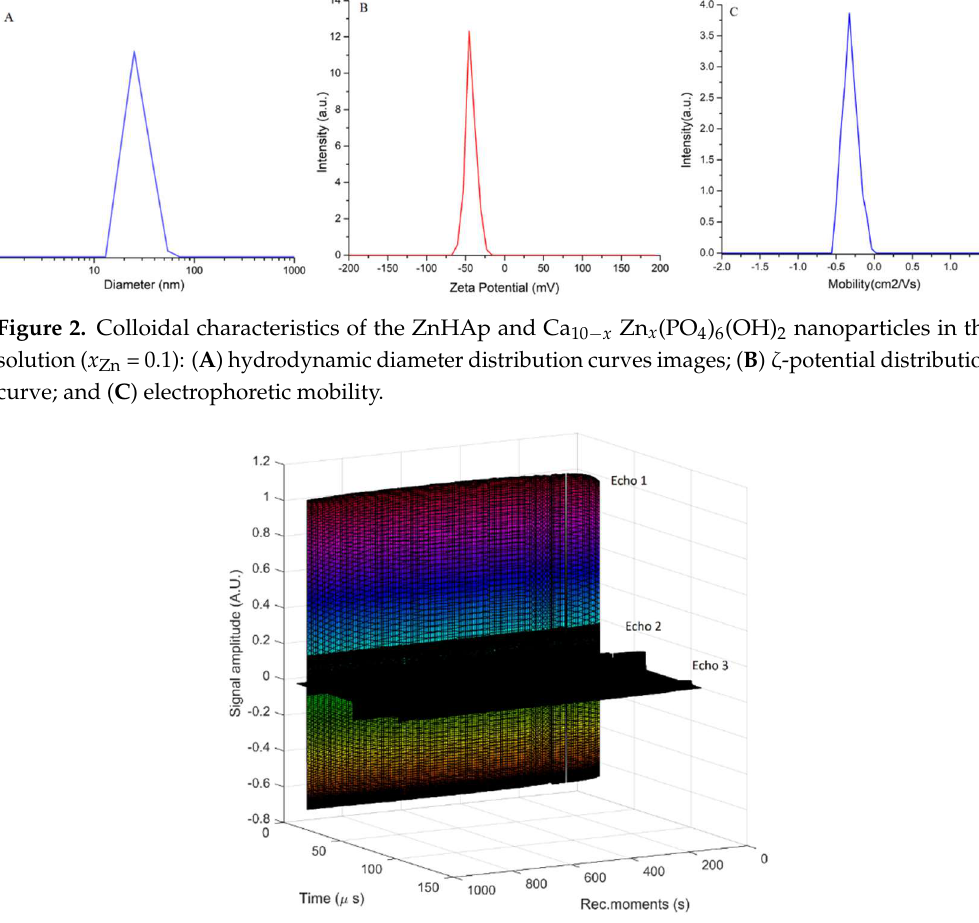
Figure 3. Recorded T signals for 1000 s. Each signal includes three echoes.